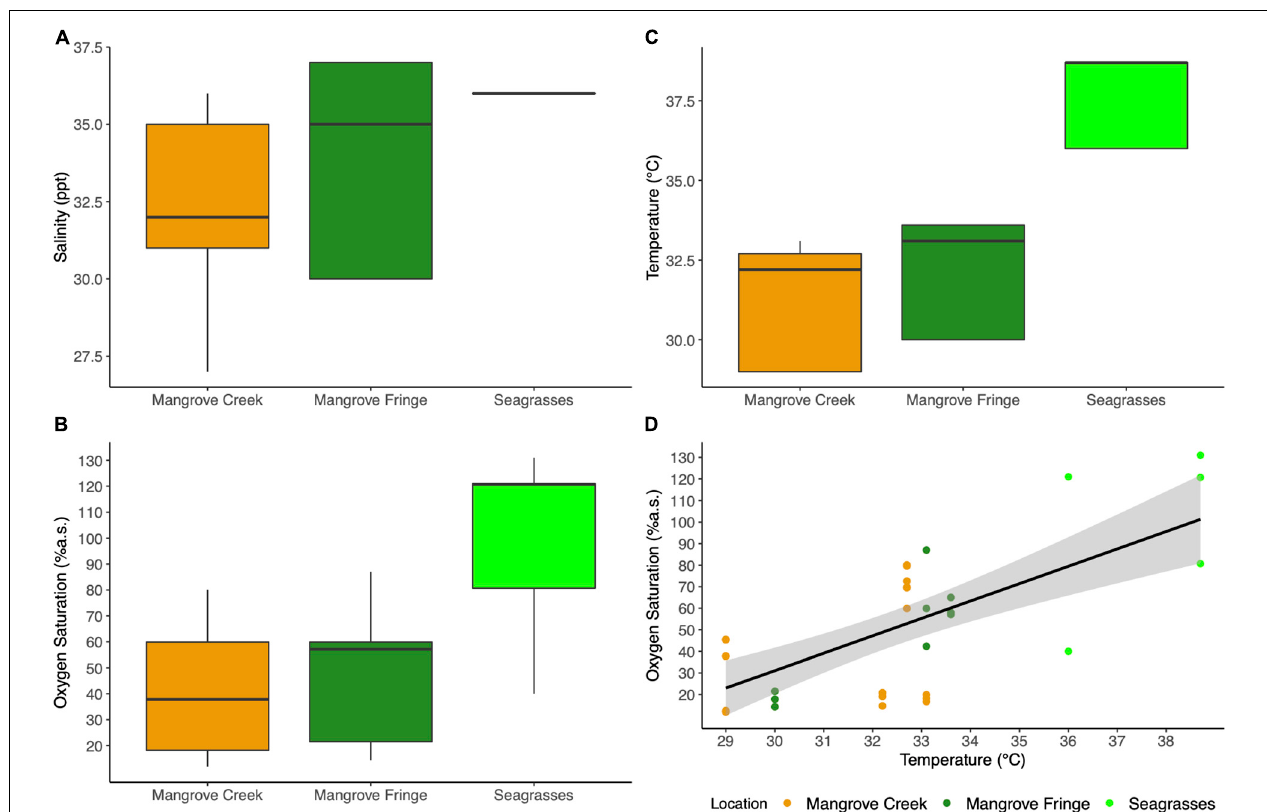
FIGURE 2 | Environmental conditions recorded at low spring tide during the day (11 a.m.–2 p.m.). (A) Salinity, (B) oxygen saturation, (C) temperature of the aquatic habitat colonized by T. crenata . (D) Correlation between temperature and oxygen saturation among the three habitats investigated (Pearson correlation 0.69, t = 5.5965, df = 33, p <